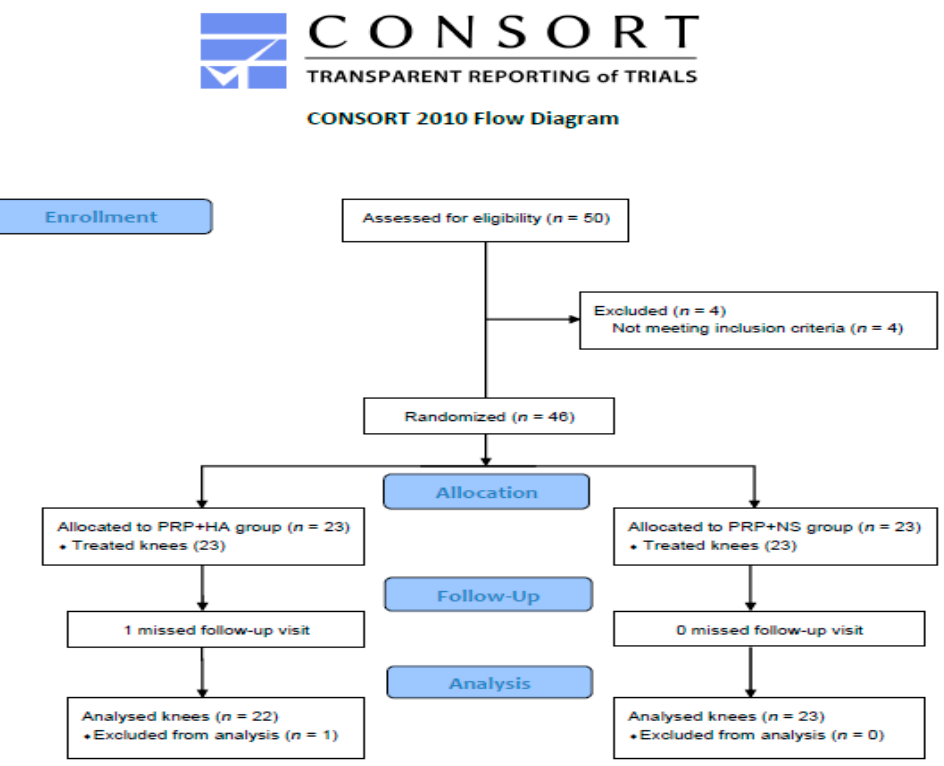
Figure 1. Study flow diagram.